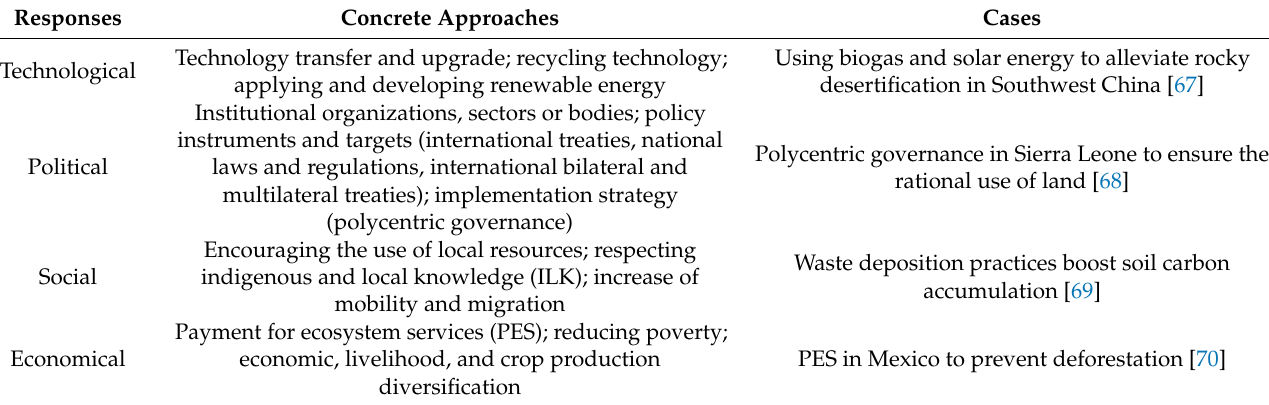
Table 1. Responses to telecoupling for sustainable land